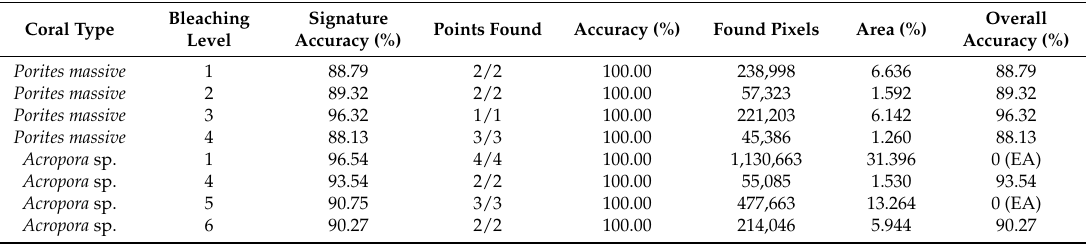
Table 4. Material classification accuracy assessment for Figure 22 at Pandora Reef where regions with spume region marker in Figure 5 are excluded.